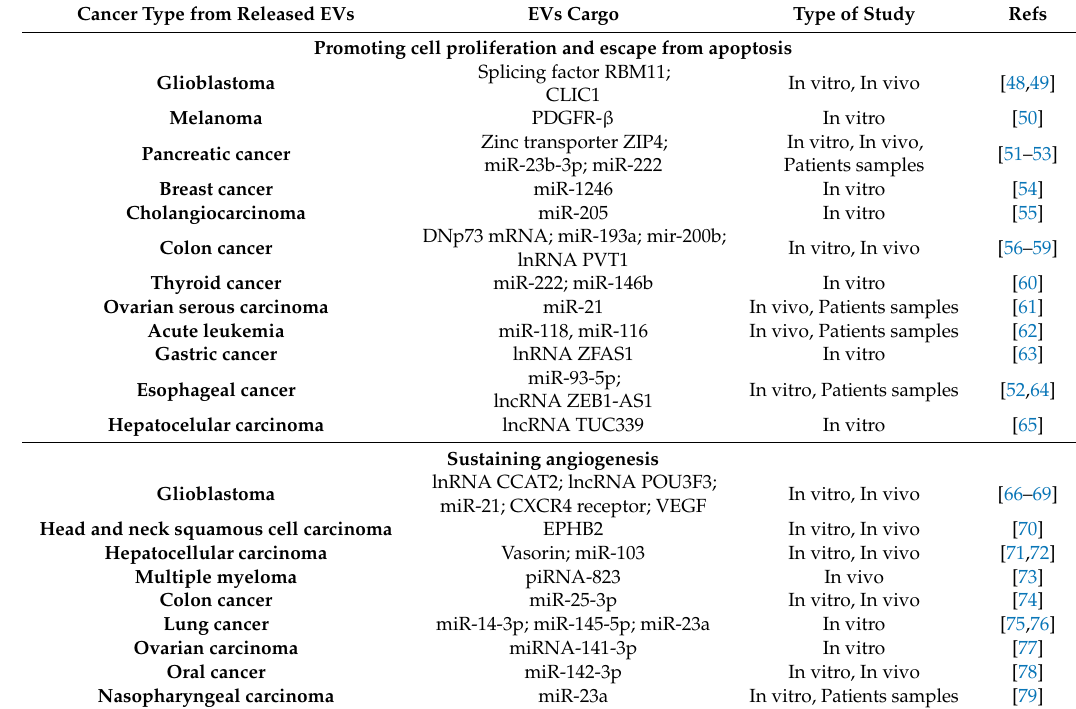
Table 1. EVs cargo derived from di ff erent types of cancers with impact in the tumor hallmarks. Cancer Type from Released